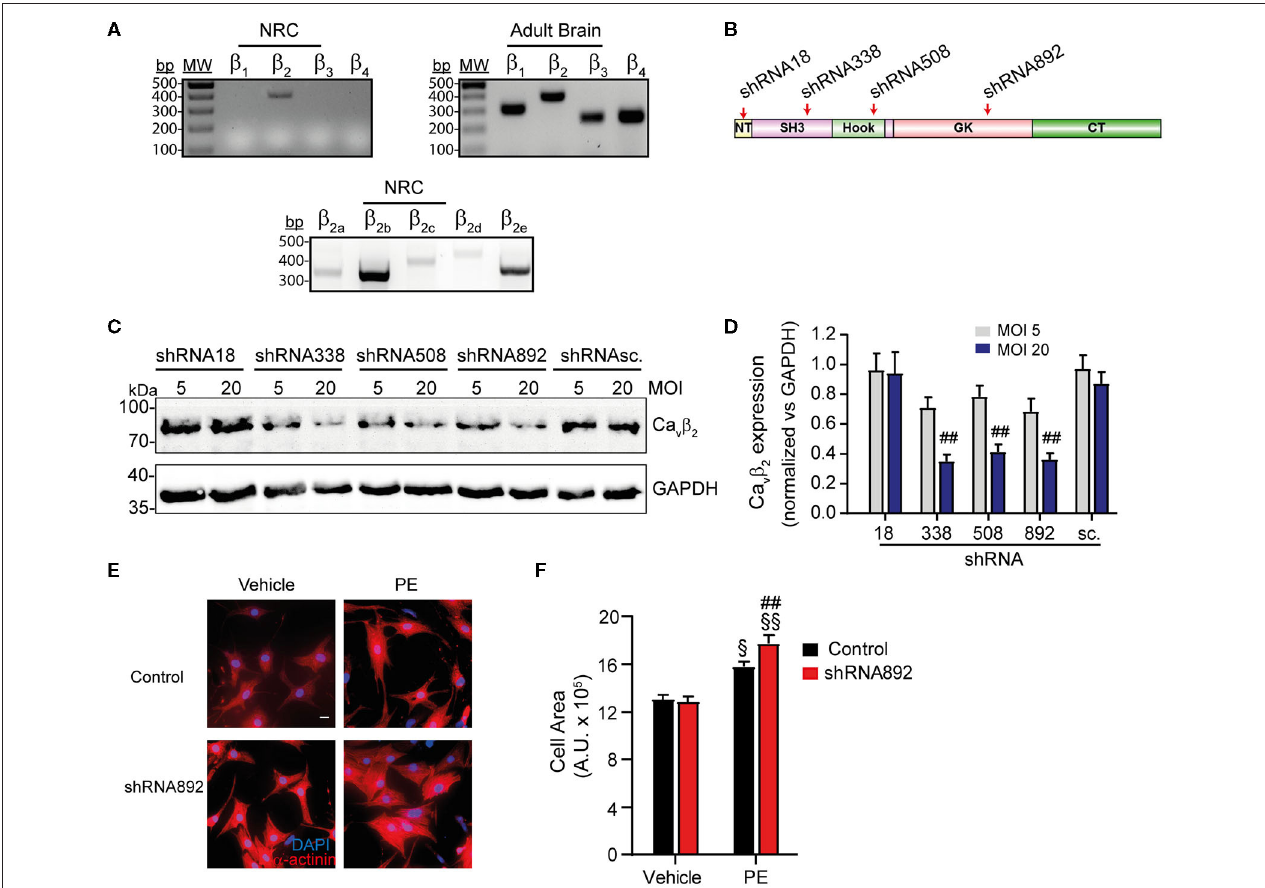
FIGURE 1 | Ca v β 2 downregulation enhances PE-induced hypertrophy of NRCs. (A) RT-PCR analysis of the expression of the four Ca v β isoforms in NRCs and adult brain. The lower panel shows the expression of the different Ca v β 2 splice variants in NRCs. (B) Scheme of the domain organization of Ca v β 2 , showing the regions where the designed shRNAs bind: NT (N-terminal), SH3 (Src-3 homology domain), GK (guanylate kinase domain), CT (C-terminal). (C) Representative western blot analysis of Ca v β 2 expression in homogenates from NRCs transduced with the different shRNAs for Ca v β 2 -silencing and the scrambled shRNA (shRNAsc) used as negative control. Cells were transduced with each shRNA at an adenoviral MOI of 5 or 20. Per lane, 50 µ g of protein were loaded. An anti-GAPDH western blot was used as loading control. (D) Bar plot of Ca v β 2 expression normalized vs. GAPDH in homogenates from NRCs transduced with the different shRNAs for Ca v β 2 -silencing and the scrambled shRNA (shRNAsc.) at an adenoviral MOI of 5 or 20. Mean ± SEM from 3 replicated experiments; ## p < 0.05 vs. shRNAsc treated at the same MOI (two-way ANOVA with Holm–Sidak’s method). (E) Representative fluorescent images of control and Ca v β 2 -downregulated NRCs (shRNA892) treated with vehicle or 50 µ M phenylephrine (PE). Red, α -actinin; Blue, nuclear staining. Scale bar represents 15 µ m. (F) Bar plot of the mean values of the cell area of control and Ca v β 2 -downregulated NRCs (shRNA892) after treatments with vehicle or PE. Mean ± SEM; 150–200 cells per group from 20 randomly chosen fields from 4 replicated experiments were measured; §§ p < 0.01 vs. vehicle-treated cells in the same group; § p < 0.05 vs. vehicle-treated cells in the same group; ## p < 0.05 vs. control treated similarly (two-way ANOVA with Holm–Sidak’s